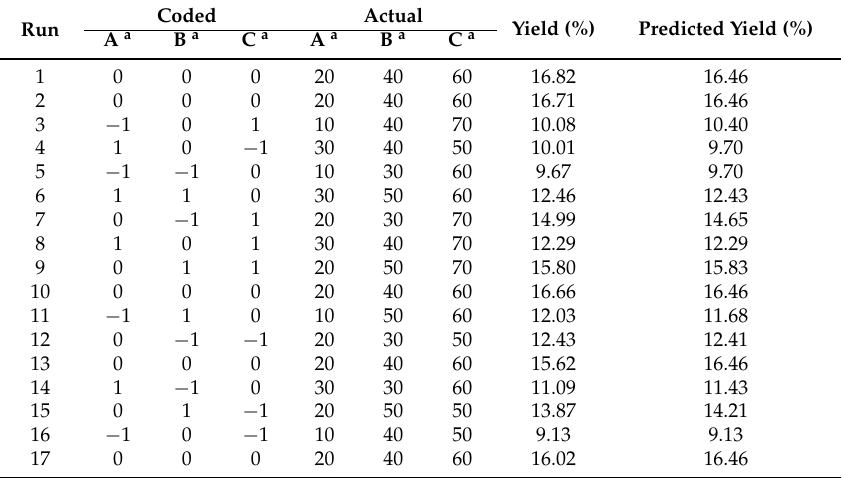
Table 1. BBD with the experimental and predicted values for the yield of PRM.